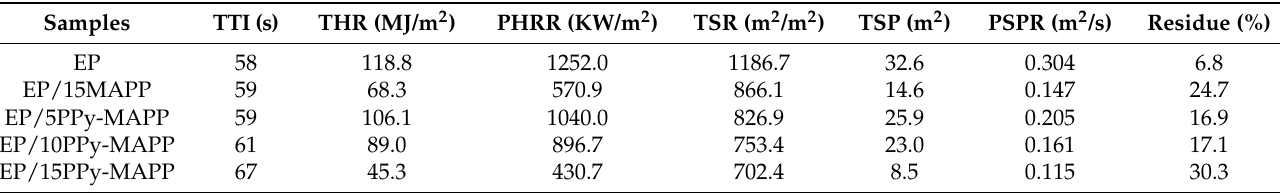
Table 3. Cone calorimeter data of pure EP and the flame-retarded EP